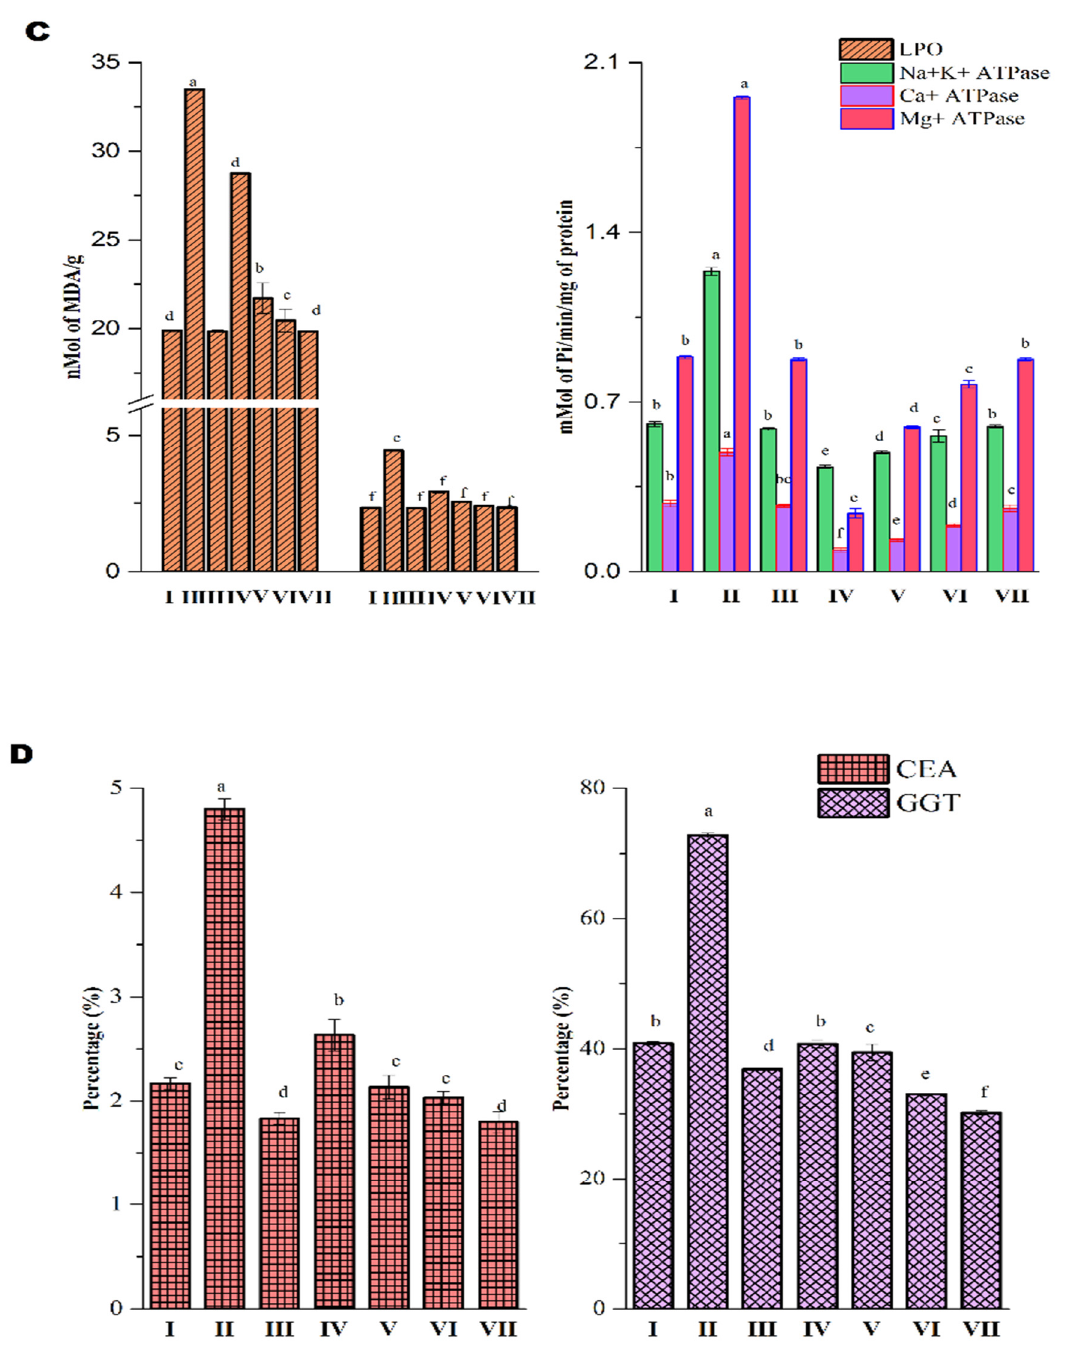
Figure 6. Determination of hematological, antioxidants, lipid peroxidation (LPO), membrane bound enzymes and tumor markers in control and treated Sprague Dawley (SD) animals. a–f Mean values with different superscripts considered as statistically different ( p < 0.05). ( A ) Hematological parameters; ( B ) Antioxidants (CAT, SOD, GPx and GSH) in serum and tissues; ( C ) LPO and membrane bound enzymes in serum; ( D ) carcinogenic markers—CEA and GGT. All the graphs ( A – D ) are represented in mean ± standard deviation ( n = 3). Different alphabets (a–j) indicate significant differences among treatments ( p < 0.05)—based upon the differences between the experimental groups) according to Tukey’s HSD test.